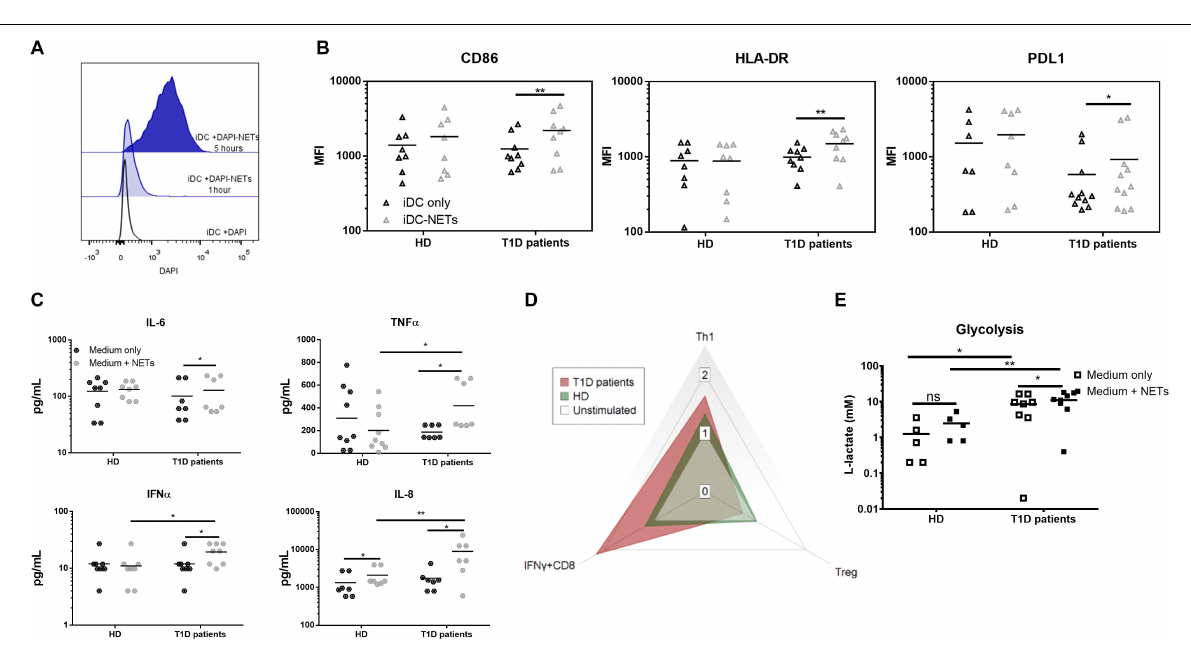
FIGURE 2 | Monocyte-derived dendritic cell functional analysis. (A) Representative histogram of the interaction between moDCs and autologous NETs dyed with DAPI. (B) CD86, HLA-DR and PDL1 expression in the moDC co-cultured with or without autologous NET from 9 T1D patients (67% female) and 8 healthy donors (62% female) detected by flow cytometry. (C) Cytokine production by moDCs from 7 T1D (57% female) and 8 healthy (62% female) donors co-cultured with or without autologous NET analyzed by Luminex. (D) Radar graph displaying a shift between T cell populations induced by moDCs co-cultured with or without autologous NET. Data are expressed as the median of the response index (% of cells cultured with NETs/% of cells cultured without NETs). T cell populations analyzed by flow cytometry are defined as Th1 (IFN γ +CD4), Treg (FoxP3+CD25 hi CD127-CD4) and IFN γ -producing CD8+ lymphocytes. (E) moDCs of 8 T1D (62% female) and 5 healthy (60% female) donors were incubated with or without autologous NETs for 24 h, and then the L -lactate concentration in the culture supernatant was measured as an indicator of glycolytic activity by ELISA. Statistical analysis was performed using a two-tailed Wilcoxon paired t -test and an unpaired t -test. Values of p < 0.05 (*), p < 0.01 (**) and p < 0.001 (***) were considered statistically